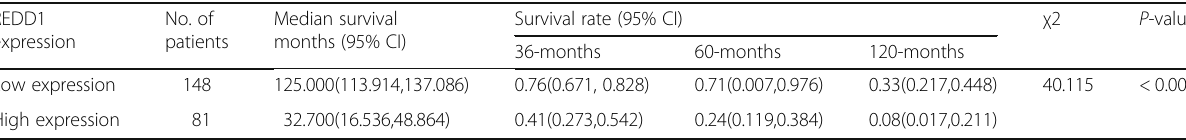
Table 4 Cytoplasmic REDD1 expression and OS REDD1 expression